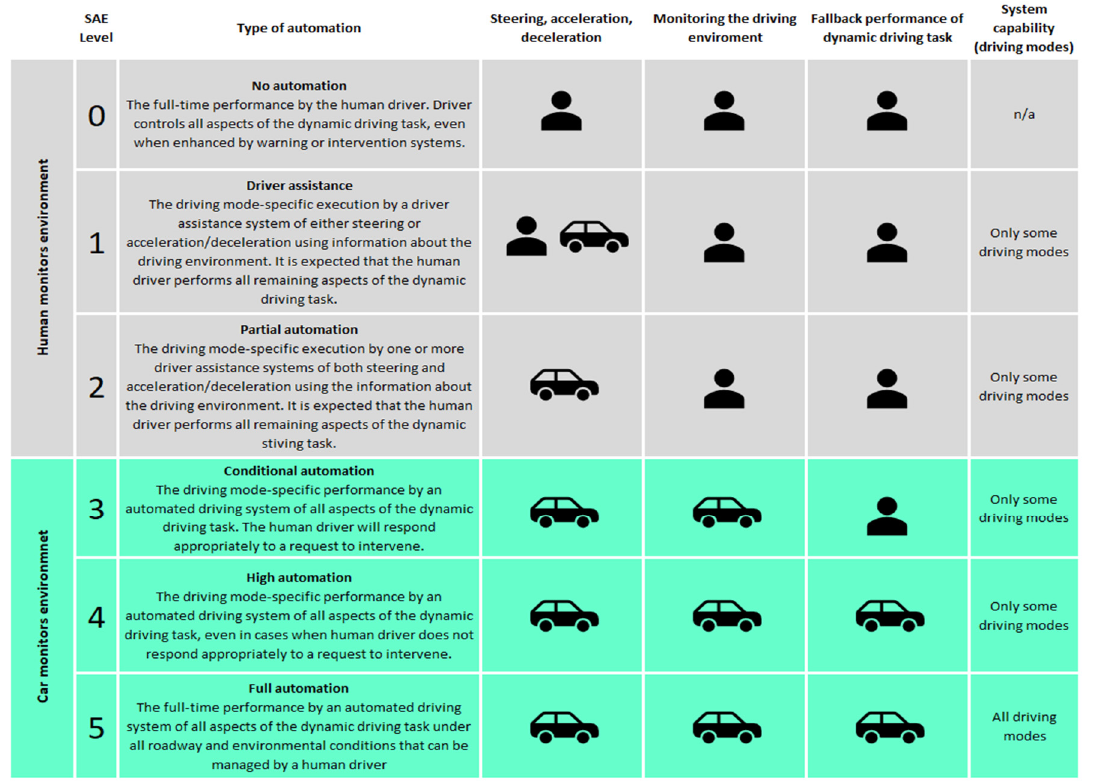
Figure 3. Classification and description of individual levels of autonomy according to SAE